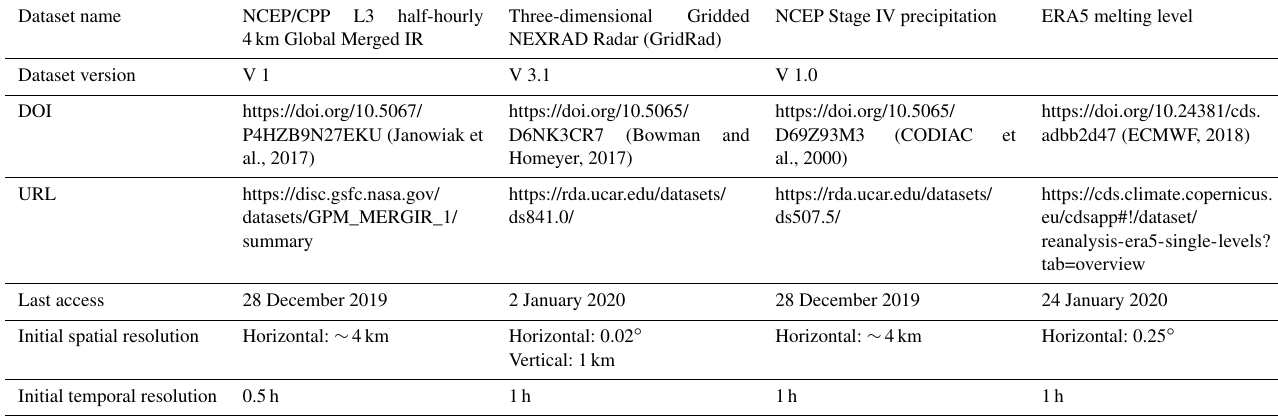
Table A1. Summary of source datasets used to develop the MCS–IDC data product.